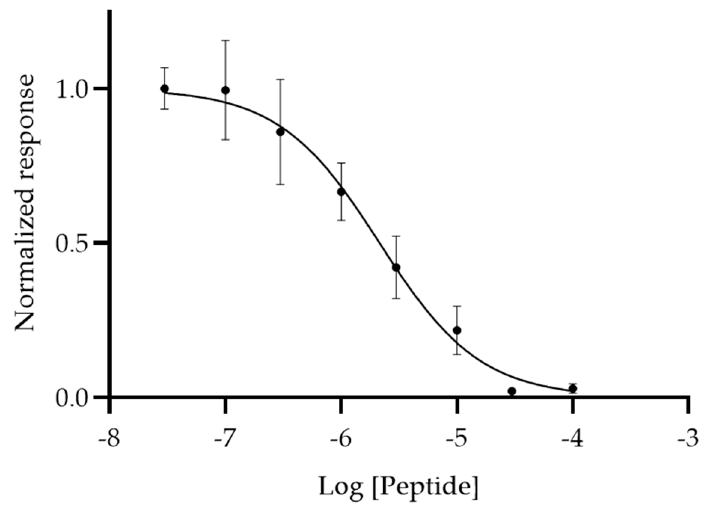
Figure 4. Dose–response study of MCA1 binding to Mia Paca-2 cells. Varying concentrations (0.03–100 µM) of GSG-MCA1 were added to the cells for 15 min, after which 30 µM biotin-GSG-MCA1 was added for 1 h. Peptides were probed with HRP-conjugated streptavidin and binding was measured spectrophotometrically at 405 nm after addition of ABTS (SpectraMax 250 microplate reader, Molecular Devices, San Jose, CA, USA). The dose–response curves were fitted using GraphPad Prism (vs. 8.3.0). The IC 50 value for MCA1 was 2.15 µM (95% CI [1.28, 3.62 µM]).